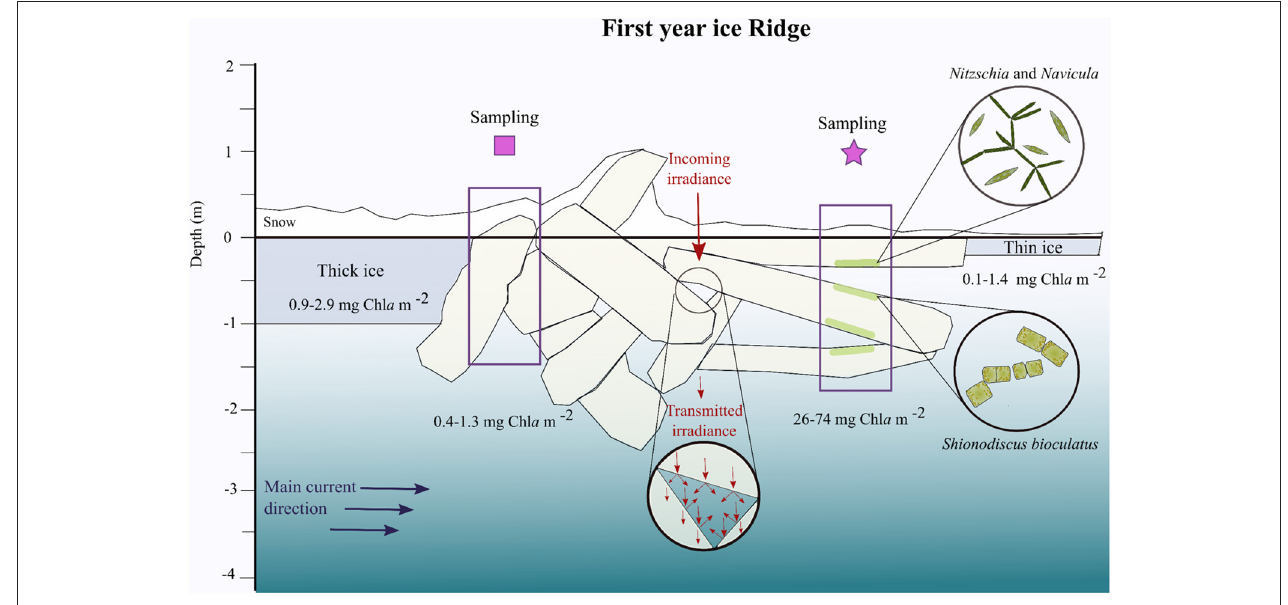
FIGURE 2 | Scheme of a first-year ice ridge based on observations and measurements performed during May 2015. The square and star correspond to the sampling sites indicated on Figure 1B . The main water current below the ice is a simplification from Figure 5C . The transmitted irradiance is depicted in a qualitative way to show the reflections that occur inside ridge cavities where the light might be higher than below the ridge itself. The most abundant algal species at the distinct surfaces of the ledges are depicted in the circles to the right based on Figure 3 .